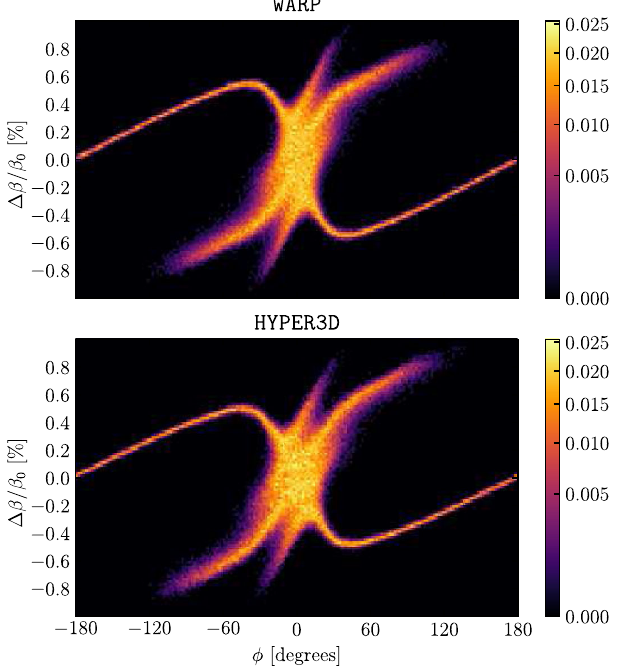
FIG. 3. The longitudinal phase space portrait measured at the final view screen for the WARP code (above) and HYPER 3 D (below) with 100,000 macroparticles. The color indicates the normalized particle